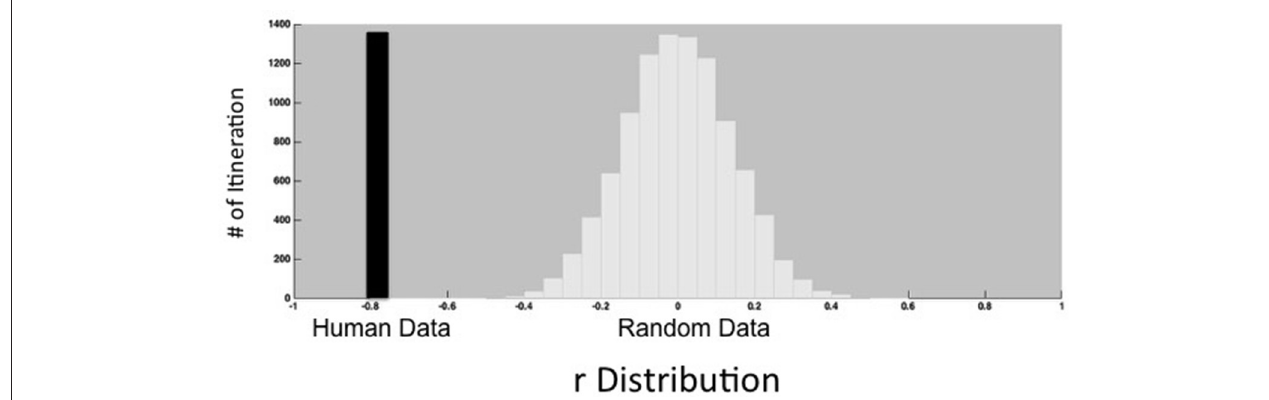
FIGURE 4 | Observed correlation between modularity and flexibility with 52 participants (black bar) compared with the distribution of the correlation between modularity and flexibility from simulations of an artificial network in which modularity is matched to the modularity values from the human subjects (white bars). The observed correlation falls well outside of the distribution of correlations from the random